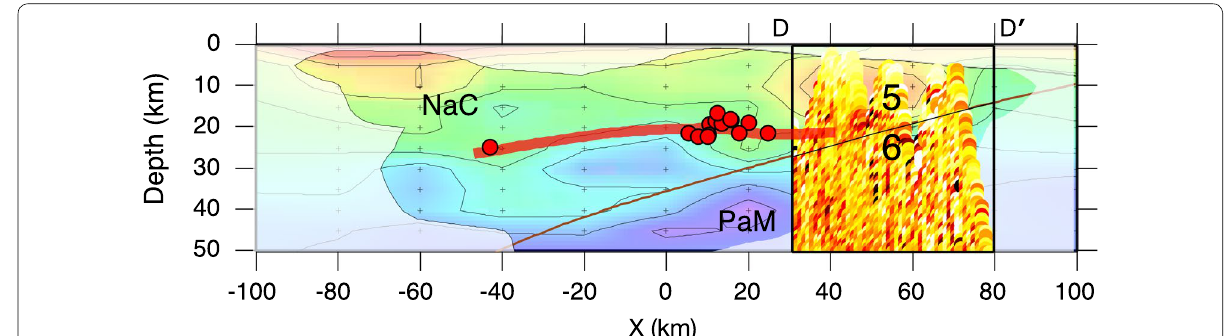
Fig. 12 The depth-domain RFs in the D–D ′ profile superimposed on the velocity structure at Y proposed upper boundary of the PHS, which is projected on Y thrust-faulting earthquakes used to estimate the upper boundary of the